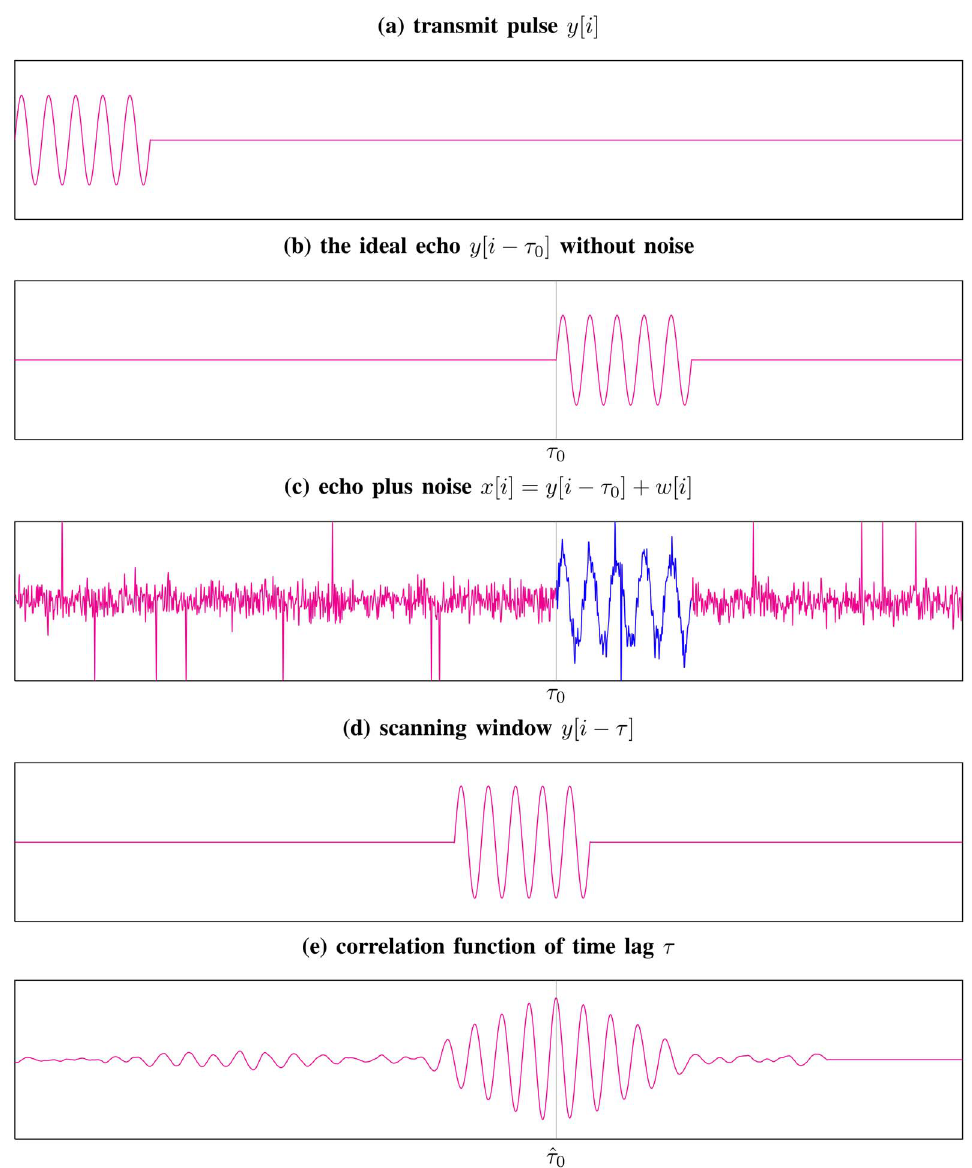
Figure 3. Schematic illustration of estimating the time-delay t 0 in Model (4). The time-shift ^ tt 0 with respect to the maximum of the correlation function in the bottom panel is considered as an estimate of the true time-delay t 0 .